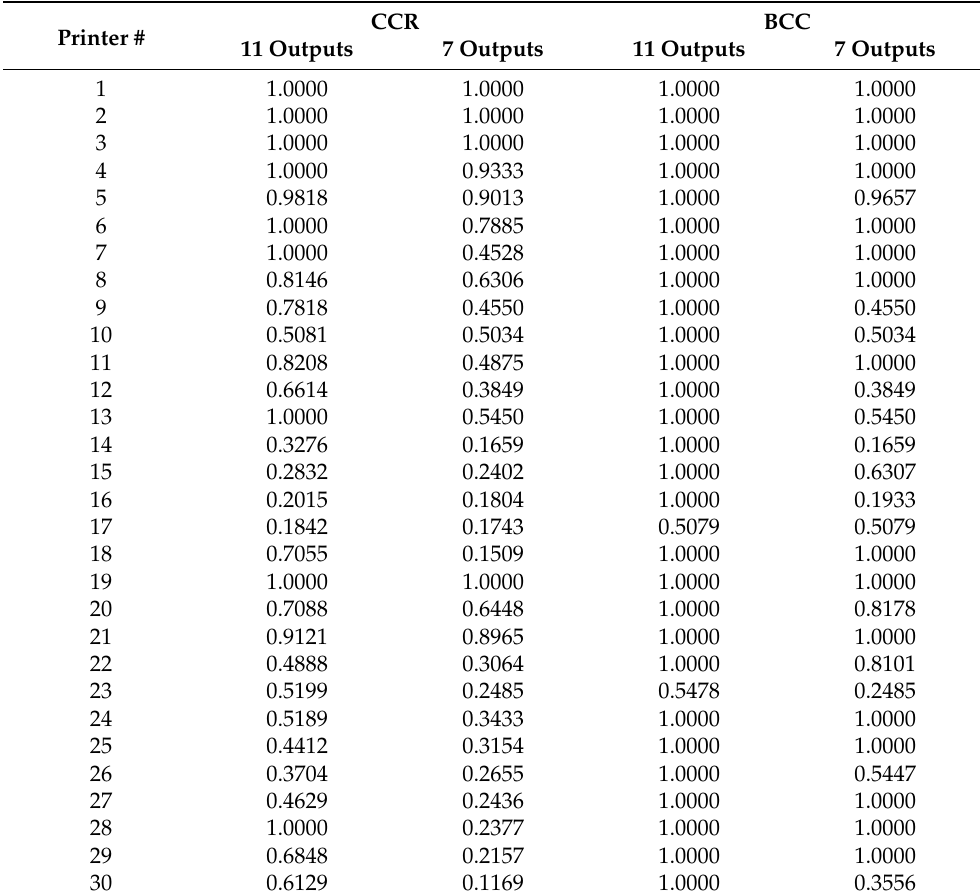
Table 4. Results of CCR and BCC DEA evaluation of printers, considering all eleven output parame- ters and only seven of